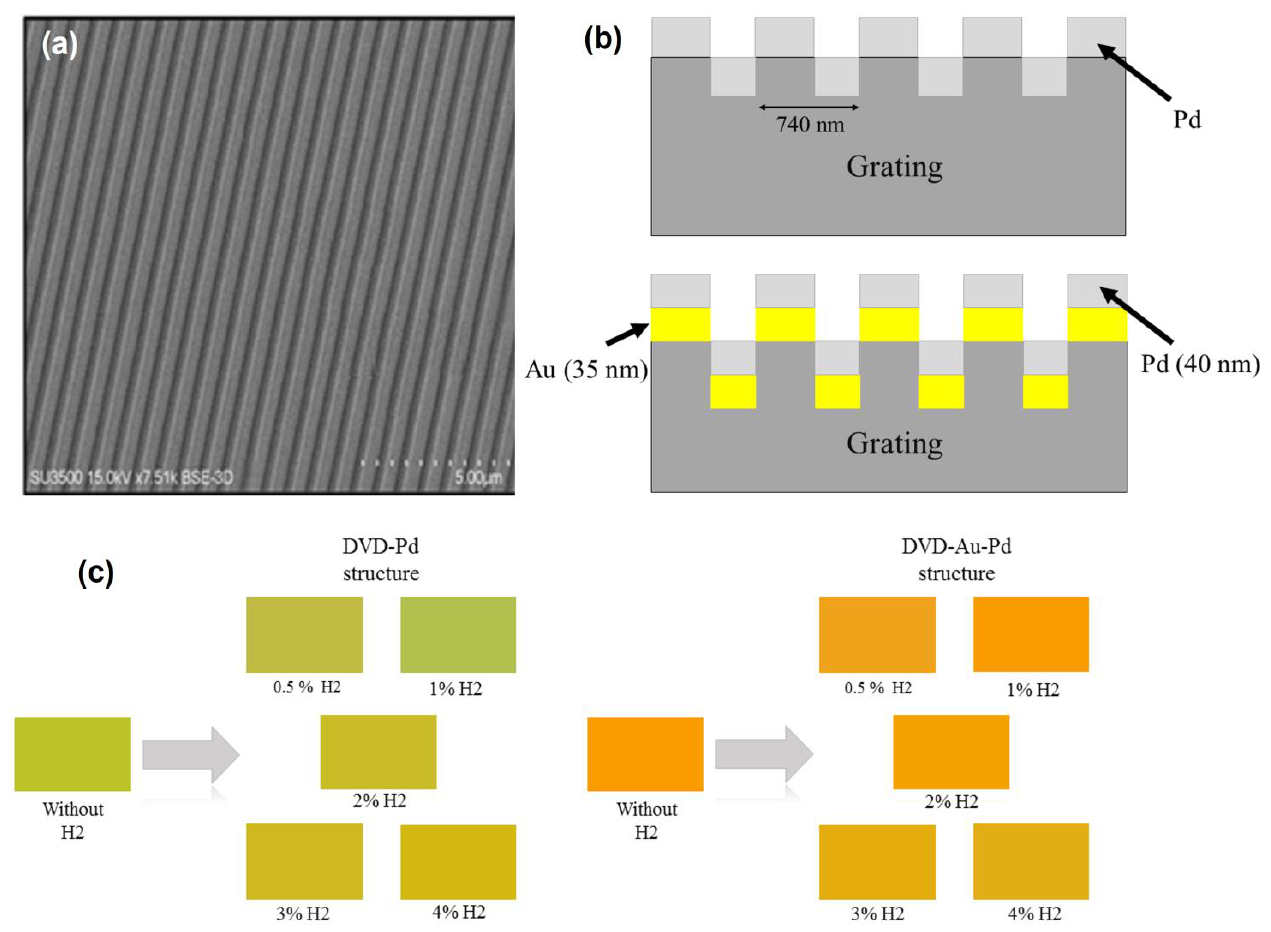
Figure 3. Physical and color structure of the prototyped sensor. ( a ) Scanning electron microscope image of nano-grating. ( b ) Schematic cross-sections of the nano-grating/Pd and nano-grating/Au/Pd structures. ( c ) MATLAB simulations of color changes of the Pd layer due to hydrogen adsorption at different concentrations (vol.%) according to the CIE 1931 color space diagram for the (left): DVD/Pd structure and (right): DVD/Au/Pd structure.